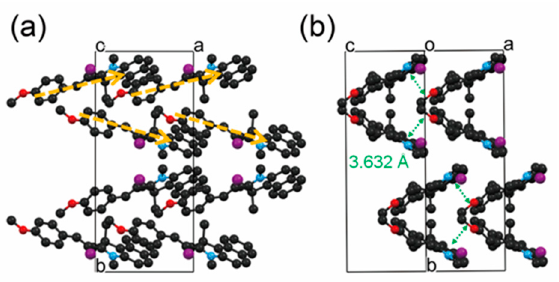
Figure 15. ( a ) Molecule arrangement in the MBI crystal structure along the c -axis; ( b ) face-to-face π - π stacking in MBI (3.632 Å) [55].